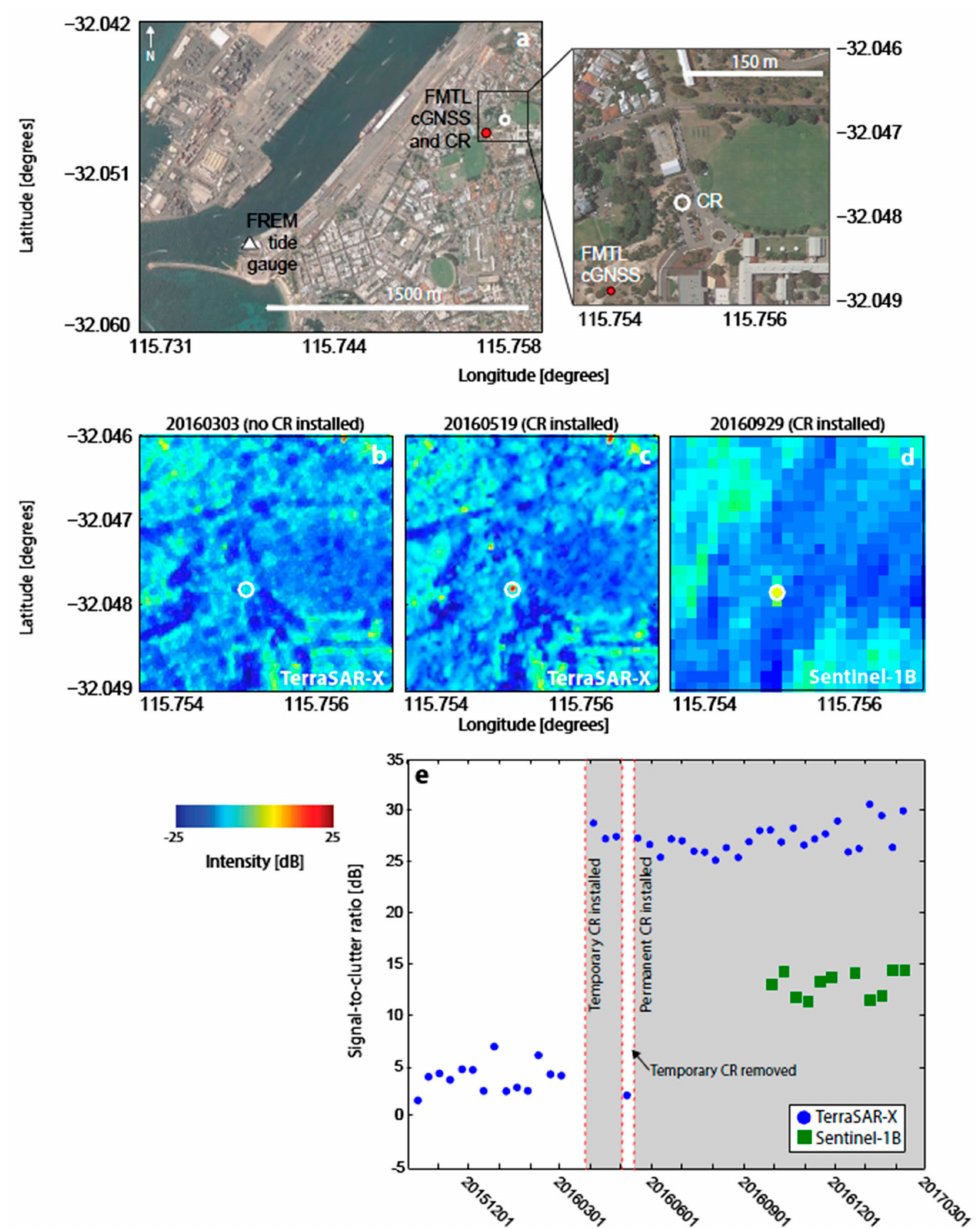
Figure 5. Corner reflector (CR) installation at John Curtin College of the Arts, ~1.5 km from the Fremantle tide gauge (labelled FMTL in Figure 1). ( a ) Google Earth view of the site showing the location of the tide gauge (white triangle), cGNSS (red dot) and CR location (white circle). Inset: enlarged view of the site showing the same area as (b–d). ( b ) TSX georeferenced backscatter intensity image prior to CR installation. ( c ) Same as for (b) but after CR installation. ( d ) Sentinel-1B georeferenced backscatter intensity image after CR installation. ( e ) Time series of signal-to-clutter ratio (SCR) at the location of the CR. Red lines and grey boxes indicate times when the CR was